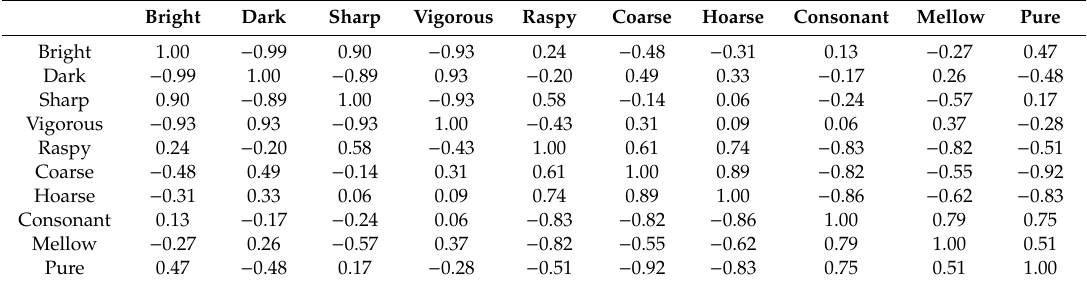
Table 4. A correlation matrix for 10 timbre evaluation terms.